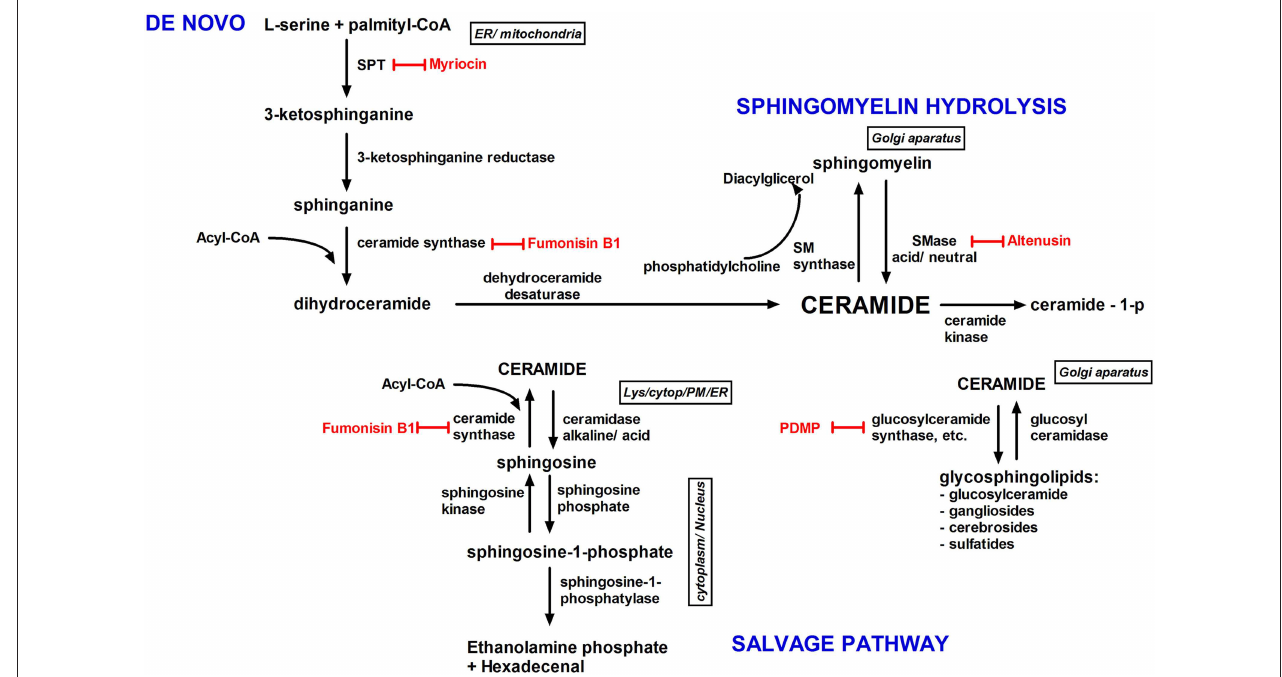
FIGURE 3 | Ceramide biosynthesis pathways and their subcellular localization. Ceramide is synthesized by three pathways; the de novo pathway; the sphingomyelin pathway; and the salvage/recycling pathway. The de novo synthesis pathway (endoplasmic reticulum), begins by the condensation of serine with palmitoyl-CoA by serine palmitoyltransferase into dihydrosphingosine. Next, dihydrosphingosine is converted into ceramide. In the salvage pathway, sphingosine is metabolized into ceramide by ceramide synthase, and glucosylceramide is degraded into ceramide by glucosylceramidase. The recycling pathway is accountable for the cycling among ceramide and complex sphingolipids. In the sphingomyelin hydrolysis pathway, plasma membrane sphingomyelin is hydrolyzed into ceramide by sphingomyelinase. Inhibitors of ceramides metabolism are shown in red. Cytopl, cytoplasm; ER, endoplasmic reticulum; lys, lysosome; PM, plasma membrane; SMase, sphingomyelinase; SM synthase, sphingomyelin synthase; SPT, serine palmitoyltransferase. fumonisin B1) or stimulation of ceramide degradation